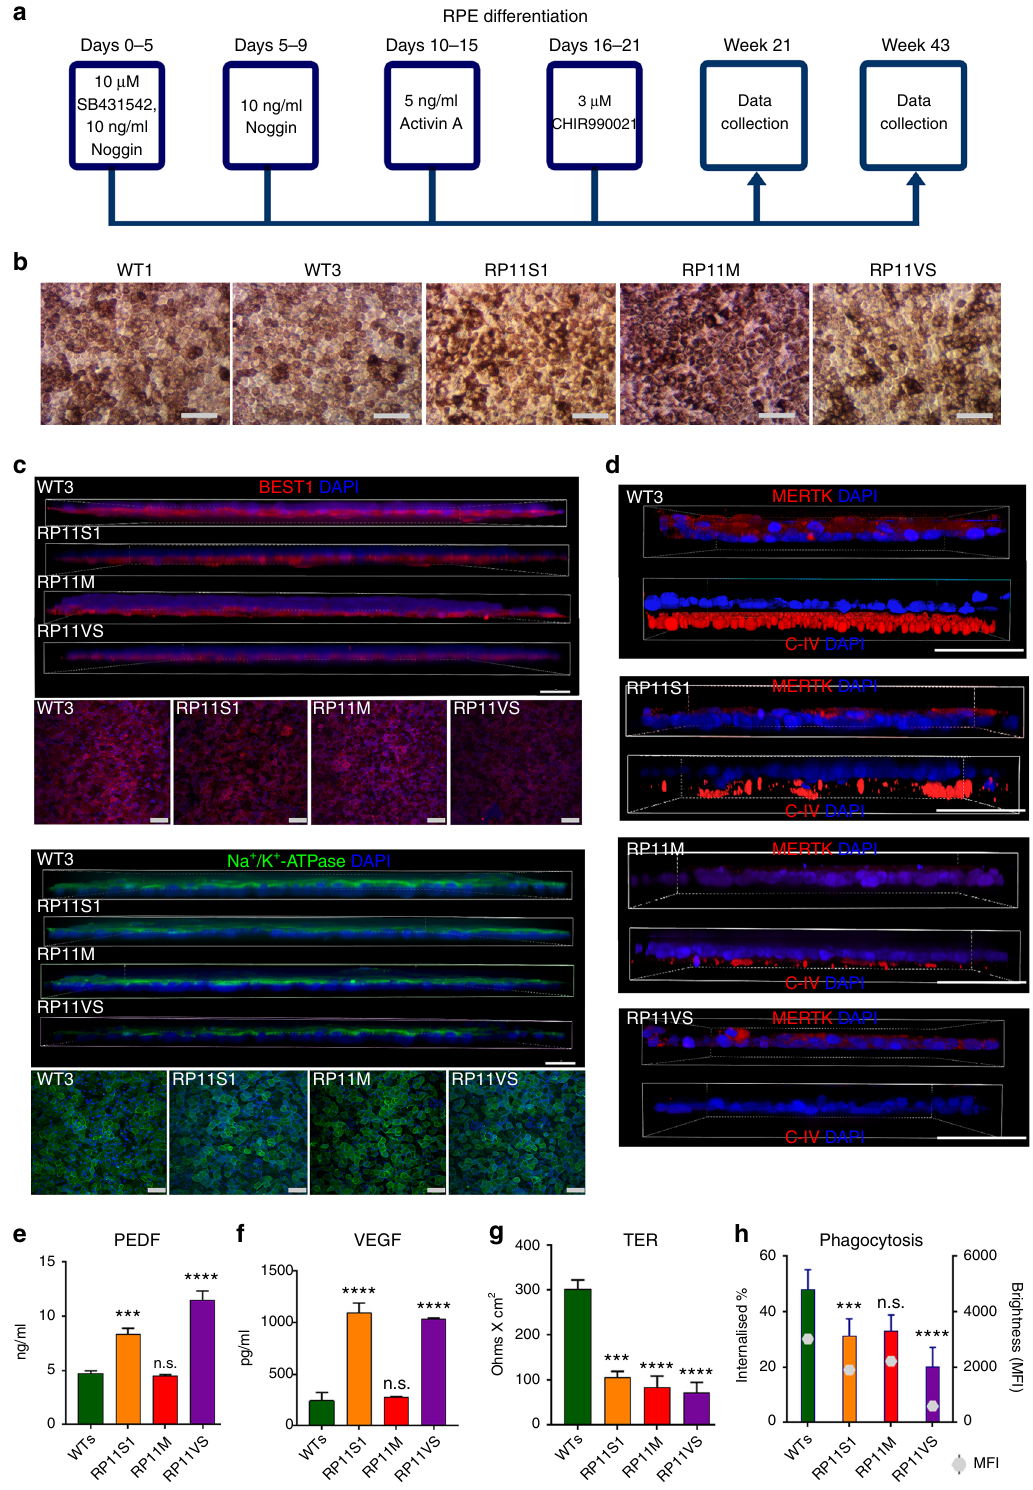
Fig. 1 Characterisation of RP11 - RPE cells revealed polarity and functional defects. a Schematic of RPE differentiation timeline; b Bright- fi eld images of iPSC- derived RPE: representative examples from at least ten independent experiments, scale bar 100 μ m; c Immunostaining for basolateral markers BEST1 and Na + /K + -ATPase: representative images from three independent experiments, scale bar 50 μ m; d Correct basolateral distribution of collagen IV (C-IV) and apical MERTK in unaffected control (WT3) but not RP11 RPE cells: representative images from three independent experiments, scale bar 50 μ m; e , f ELISA assays for apical and basal secretion of PEDF and VEGF, respectively, in control and RP11 - RPE cells; g Trans-epithelial resistance measurements revealed a signi fi cant difference between patient and RP11 - RPE cells; h Reduced phagocytic capacity in RP11 - RPE cells. Statistical signi fi cance is calculated for MFI (mean fl uorescence intensity) values. e – h Data shown as mean ± SEM, n = 3. Statistical signi fi cance of pairwise comparisons is indicated by n.s.: not signi fi cant; *** p < 0.001; **** p < 0.0001 (Student ’ s paired t test). b – h Data obtained from RPE at week 21 of